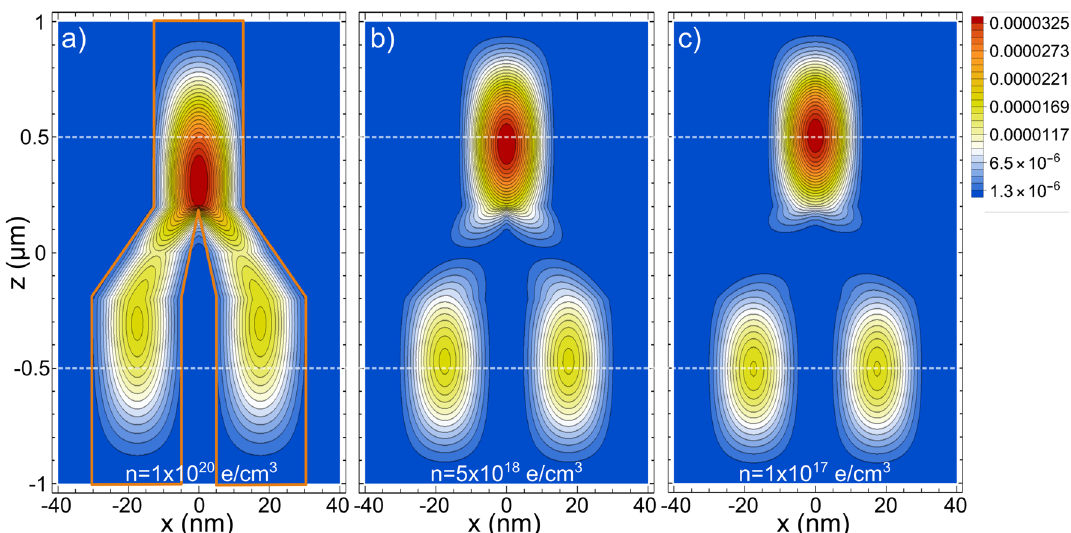
Figure 2. x – z projections of the two-electron distribution probability for the ground state of Y-Js of L x , y = 25 nm, L b = 10 nm, and length L z = 2 µ m. Three screening parameters are considered, corresponding to densities of ( a ) 1 × 10 20 electrons/ cm 3 , ( b ) 5 × 10 18 electrons/ cm 3 , and ( c ) 1 × 10 17 electrons/ cm 3 . In ( a ), the Y-J GaAs/ AlGaAs boundary is indicated. The horizontal lines are drawn to highlight the stable central positions at low